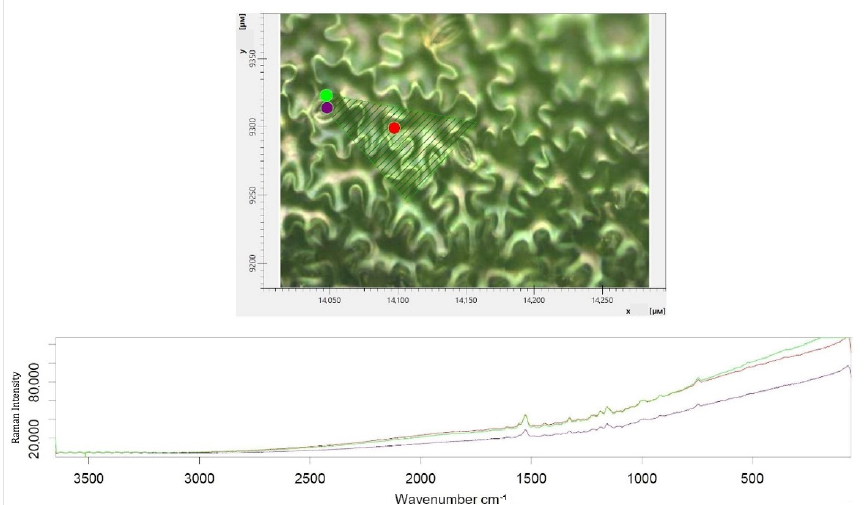
Figure 6. Measurement and selection of points on a lettuce leaf of the ‘Azart’ variety on the 35th day of cultivation, where red is the intracellular space, purple is the centre of the stomata, and green is the stomatal valve.